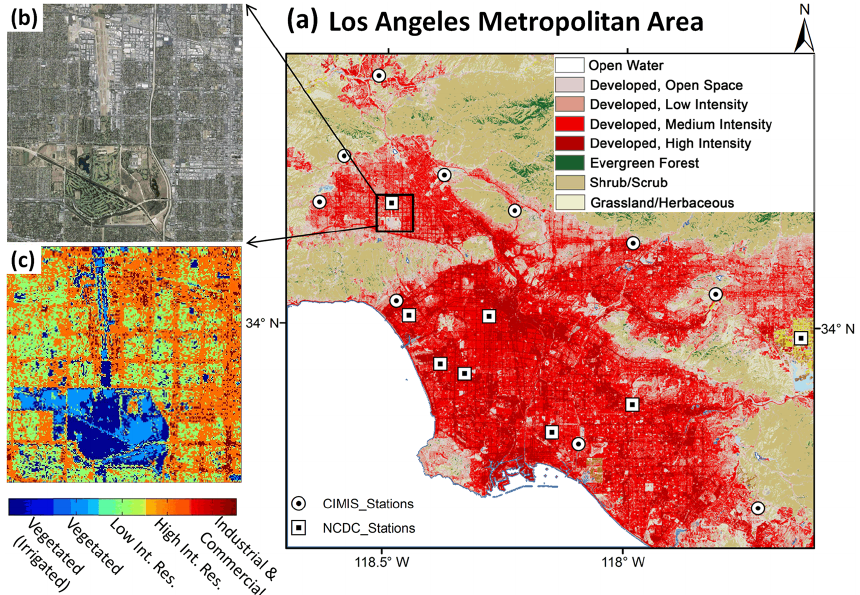
Figure 1. (a) NOAA C-CAP land cover map of the Los Angeles metropolitan area including study domain, 10 CIMIS stations (white circles), and 8 NCDC stations (white squares); (b) Google image of the study domain; and (c) the Noah-UCM urban land cover classification of the study